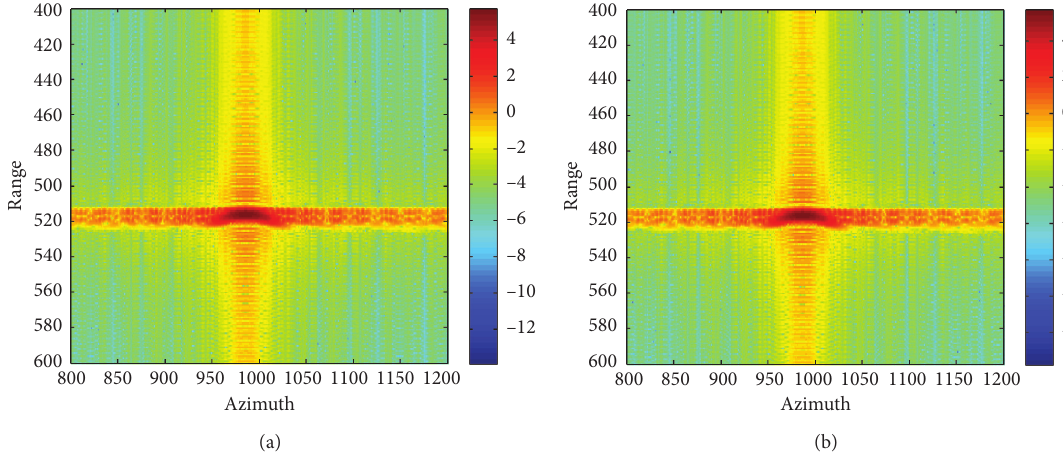
Figure 3: ATI imaging simulations: (a) simulated image of the fore channel and (b) simulated image of the aft channel.